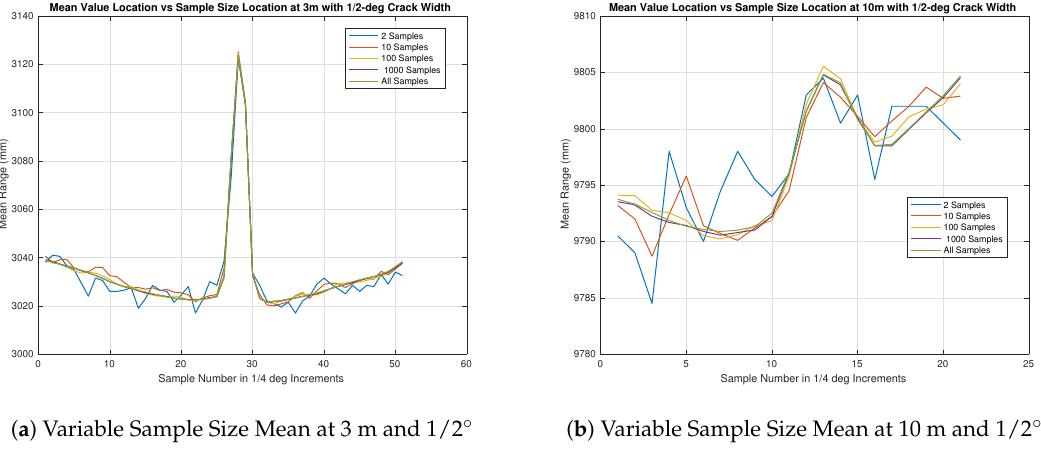
Figure 14. Comparison of angular resolution results between 3 m & 10 m range at a gap of 1/2 ◦